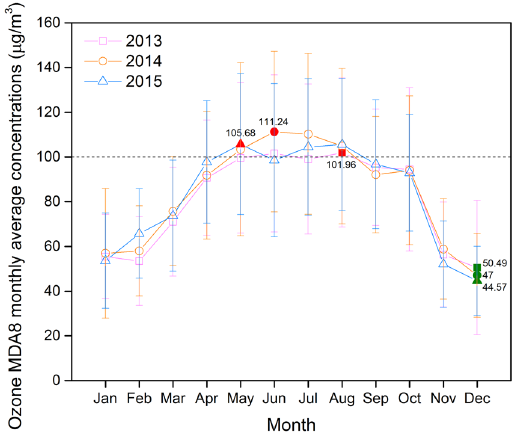
Figure 7. Monthly distribution of the maximum daily eight-hour average (MDA8) concentrations of ground- level ozone in densely populated regions of China during 2013–2015.